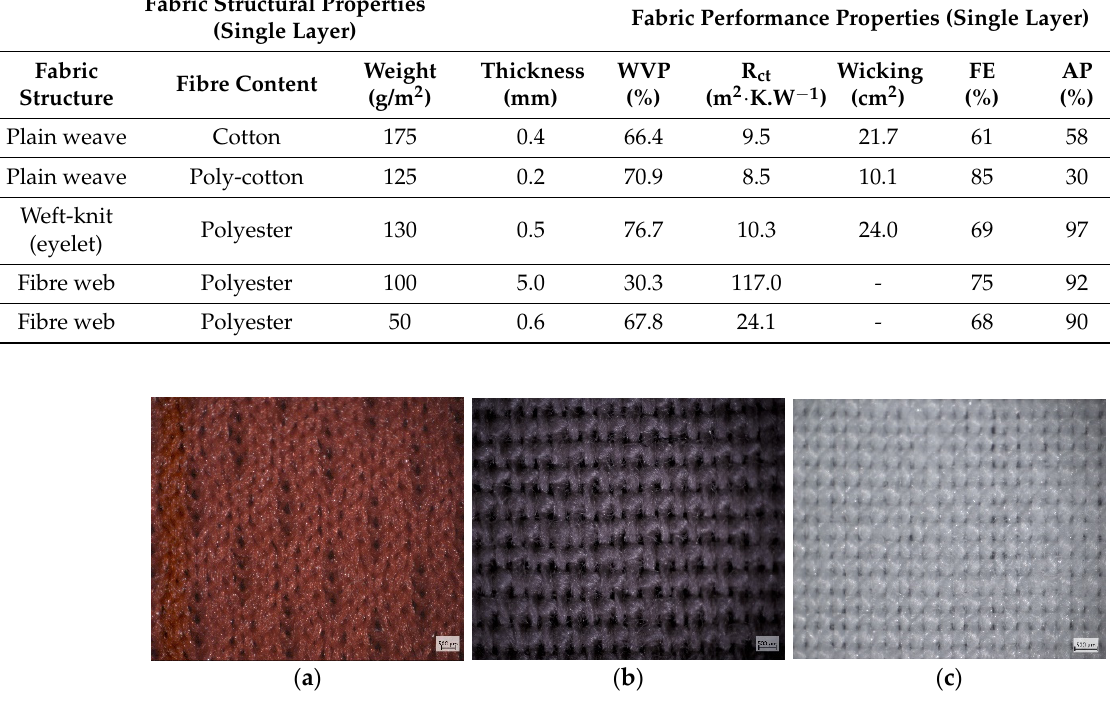
Figure 2. Microscope images of fabrics used as inner and outer layers (scale = 500 µ m). ( a ) Weft-knit polyester; ( b ) woven cotton; ( c ) woven polycotton.